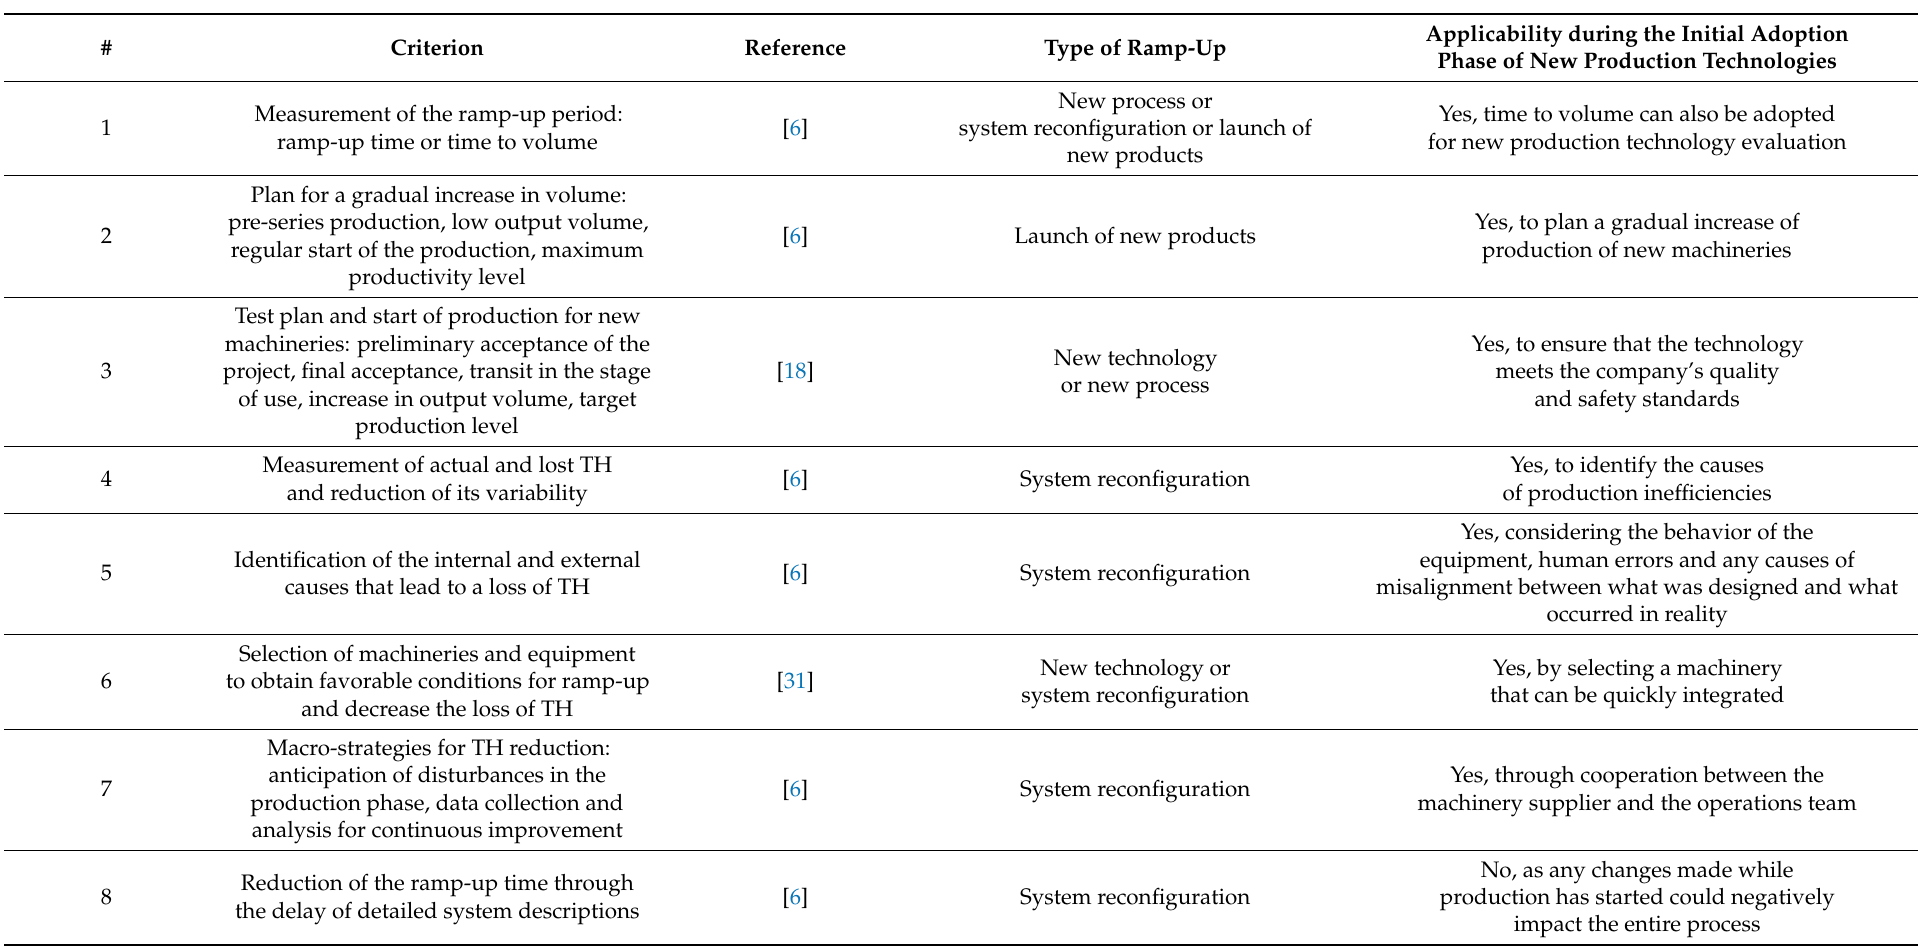
Table 1. Applicability of ramp-up criteria to the initial adoption phase of new production